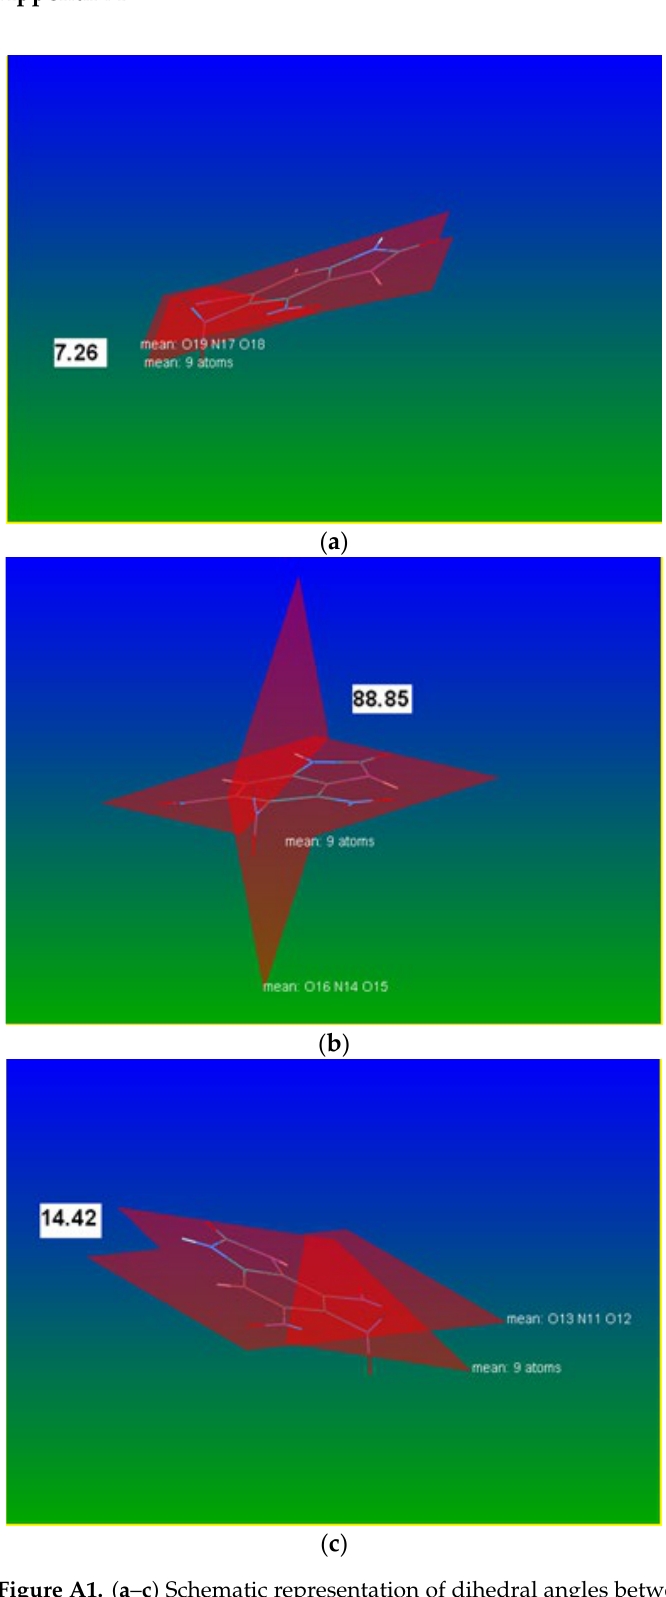
Figure A1. ( a – c ) Schematic representation of dihedral angles between 4, 5, and 6 nitrogroups and benzimidazol-2-one plane (values of angles for nitrogroups: 4-NO 2 : 7.26° 5-NO 2 : 88.85° and for 6-NO 2 : 14.42°). ( a ) 4-NO 2 . ( b ) 5-NO 2 . ( c ) 6-NO 2 .